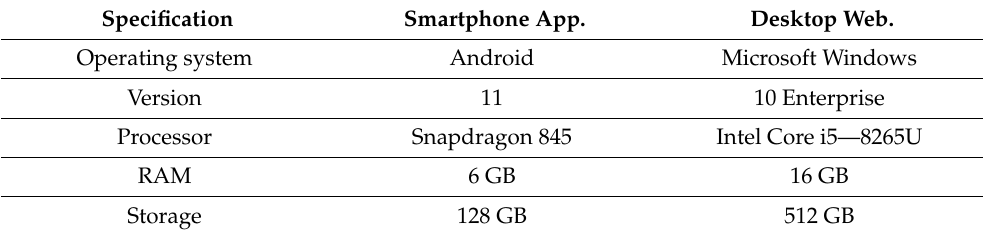
Table 4. Specifications for the two devices involved in API